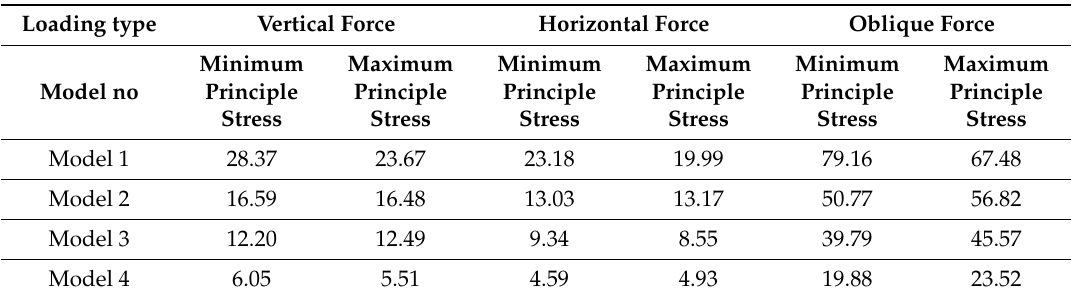
Table 3. Minimum–Maximum Principle Stress in Cortical Bone (MPa): Max: maximum principle stress; Min: Minimum principle stress.